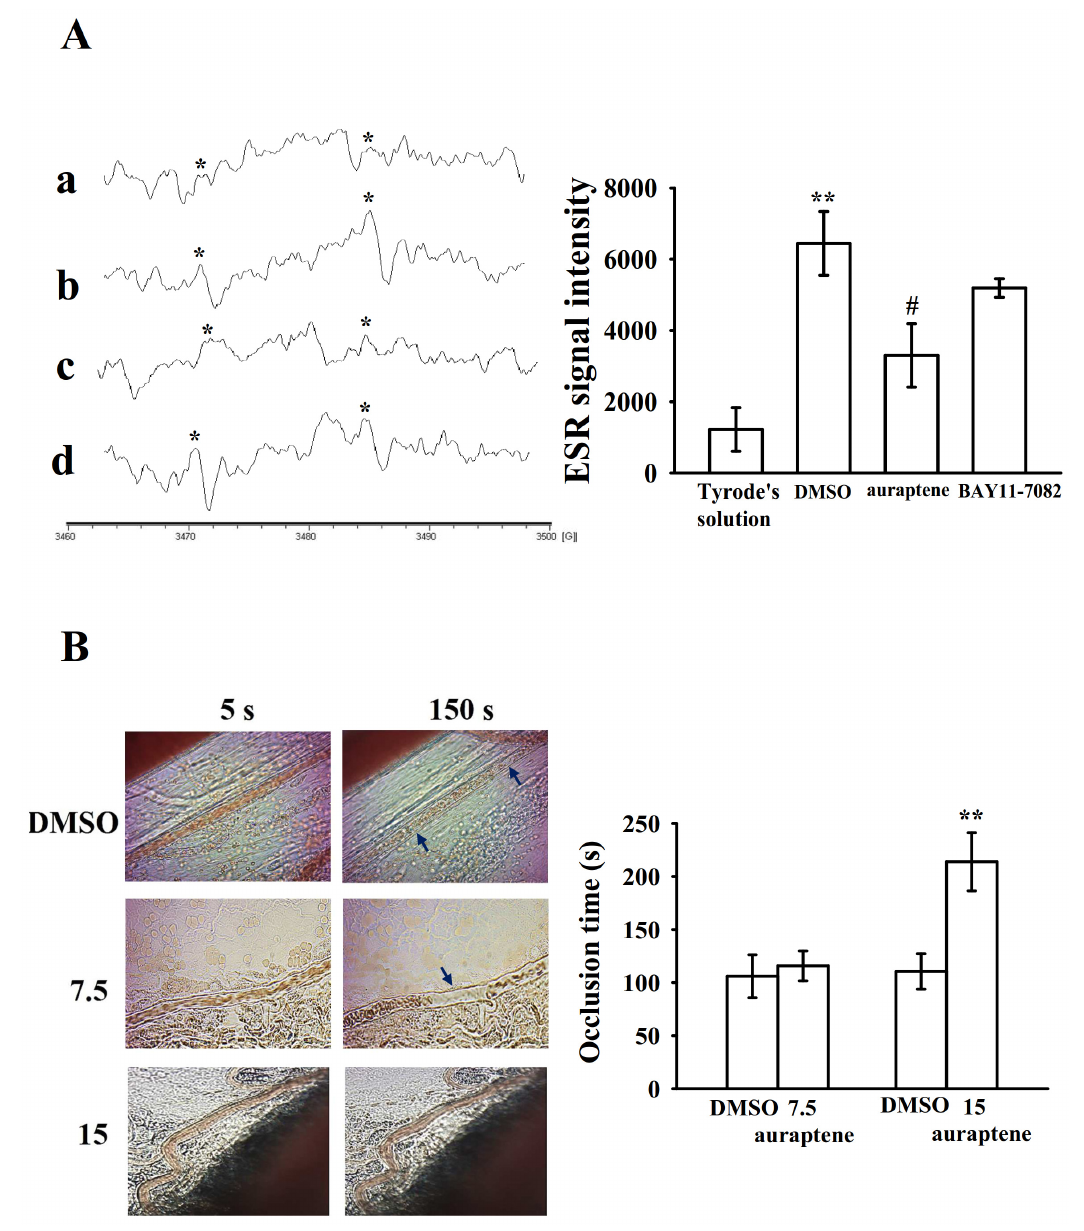
Figure 5. E ff ects of auraptene on HO • formation in human platelets and vascular thrombosis in the mesenteric venules of mice. ( A ) For the electron spin resonance (ESR) study, washed platelets were incubated with Tyrode’s solution ( a , resting group), solvent control ( b , 0.1% DMSO), auraptene ( c , 30 µ M), or ( d ) BAY11-7082 (10 µ M), followed by the addition of collagen (1 µ g / mL) to trigger HO • (hydroxyl radical) formation. An asterisk (*) indicates the formation of HO • . Spectra are representative examples of four similar experiments. Data are given as means ± SEM ( n = 4). ** p < 0.01, compared with the resting platelets (Tyrode’s solution); # p < 0.05, compared with the 0.1% DMSO-treated group. ( B ) For animal study, mice were administered an intravenous bolus of the solvent control (0.1% DMSO) or auraptene (7.5 and 15 mg / kg), and the mesenteric venules were irradiated to induce microthrombus formation (occlusion time). Microscopic images (400 × magnification) of 0.1% DMSO-treated groups and the auraptene (7.5 and 15 mg / kg)-treated groups were recorded at 5 and 150 s after irradiation, respectively. Data are given as means ± SEM ( n = 8). ** p < 0.01, compared with the 0.1% DMSO-treated group. The photographs are representative of eight similar experiments, and the arrows indicate platelet plug